Question: Compose a caption that would accompany this figure in a paper.
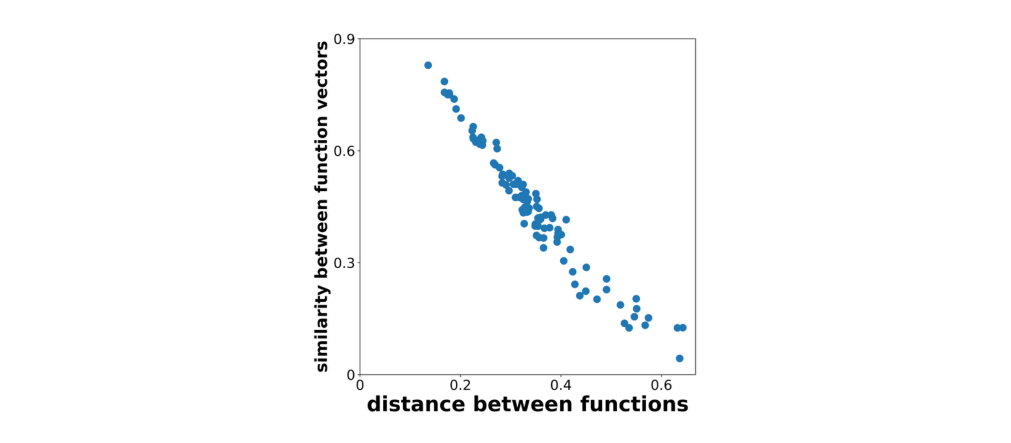
Answer: HDFE is a distance preserving transformation. The L2-distance between functions is proportional to the negative similarity between their encodings.